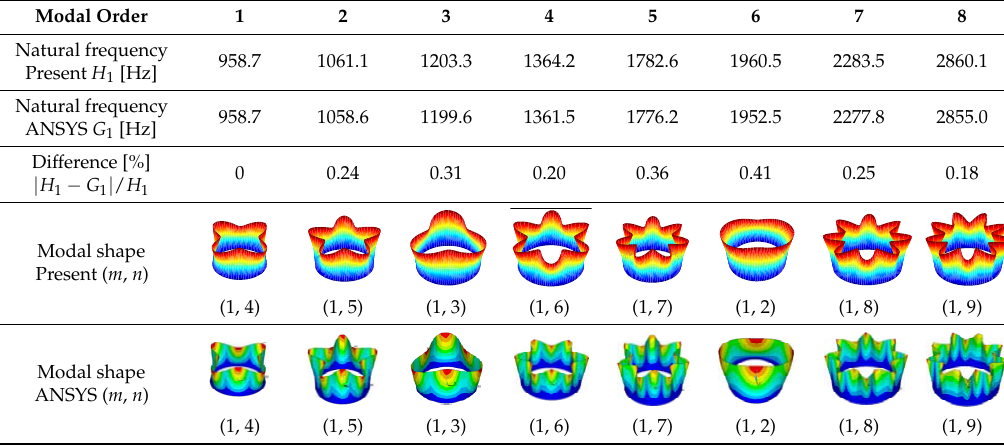
Figure 3. Finite element model of FCTS with hard coating: ( a ) Finite element model; ( b ) Schematic of hard coating and substrate. Table 3. The comparison of the first eight natural frequencies and modal shapes of the FCTS obtained by theoretical calculations and the finite element method.